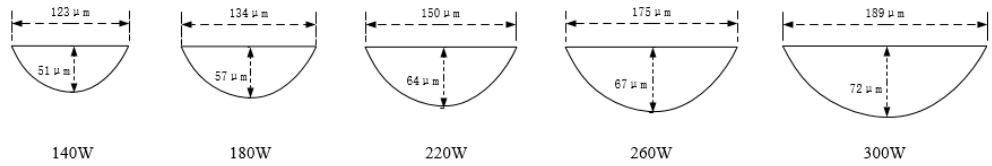
Figure 6. The geometry of a single molten pool at different laser powers.